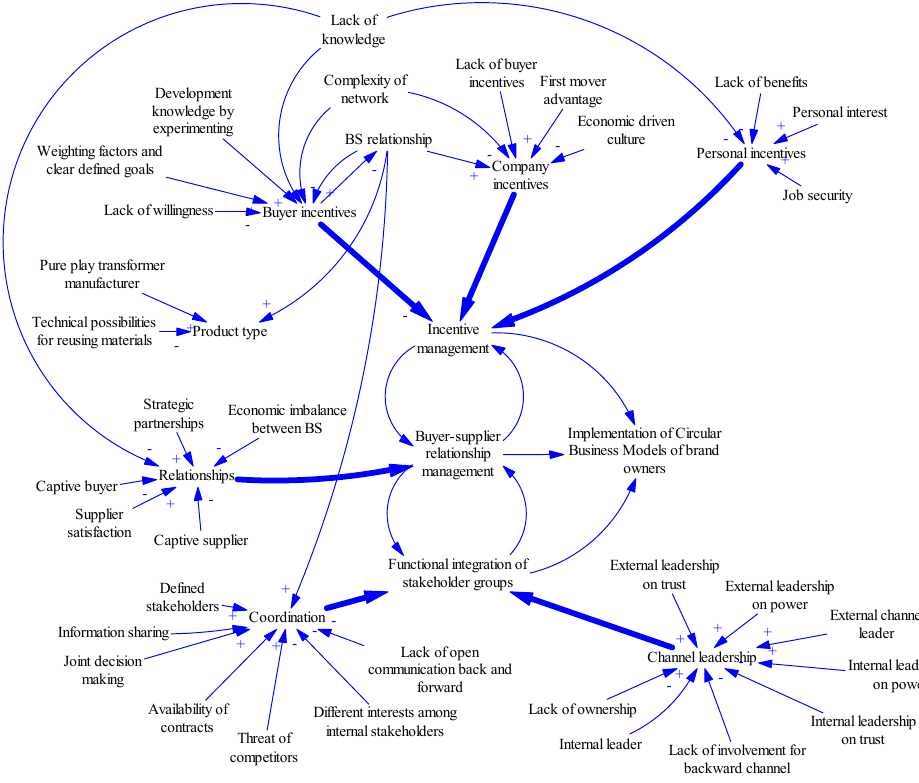
Figure 3. Causal loop diagram of the current situation (vicious cycle).